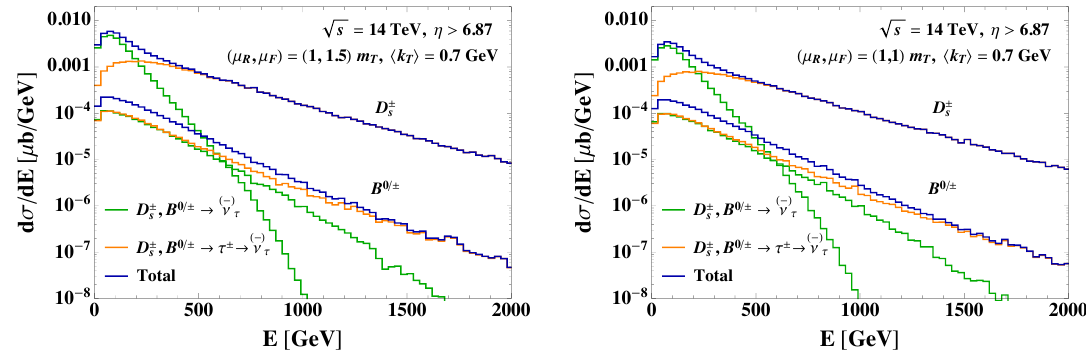
Figure 4 . The neutrino energy distributions for tau neutrinos and antineutrinos from the direct decay D (cid:6) =B 0 ; (cid:6) ! ( (cid:0) ) (cid:23) (cid:28) (green) and the chain decay D (cid:6) =B 0 ; (cid:6) ! (cid:28) (cid:6) ! ( (cid:0) ) (cid:23) (cid:28) (orange) and their sum s s p (blue) for neutrinos with pseudorapidity (cid:17) > 6 : 87, produced in pp collisions at s = 14 TeV. Predictions are obtained using as input h k T i = 0 : 7 GeV with our default scale combination ( (cid:22) R ; (cid:22) F ) = (1 : 0 ; 1 : 5) m T (left) and with the conventional scale combination ( (cid:22) R ; (cid:22) F ) = (1 : 0 ; 1 : 0) m T (right). The contributions from both D s and B mesons are shown